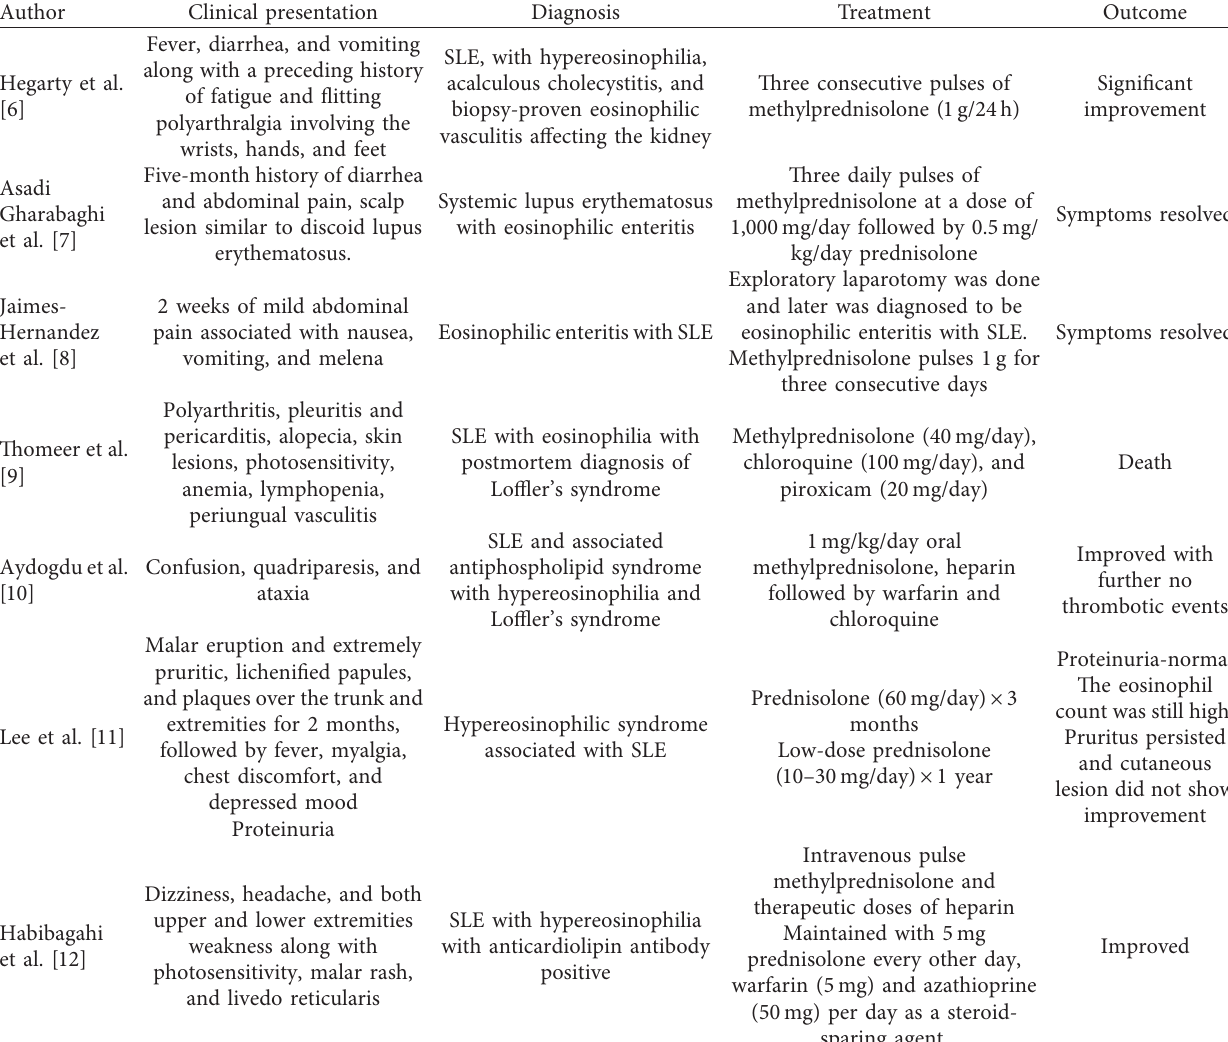
Table 3: Clinical presentation, diagnosis, treatment, and outcome of different reported